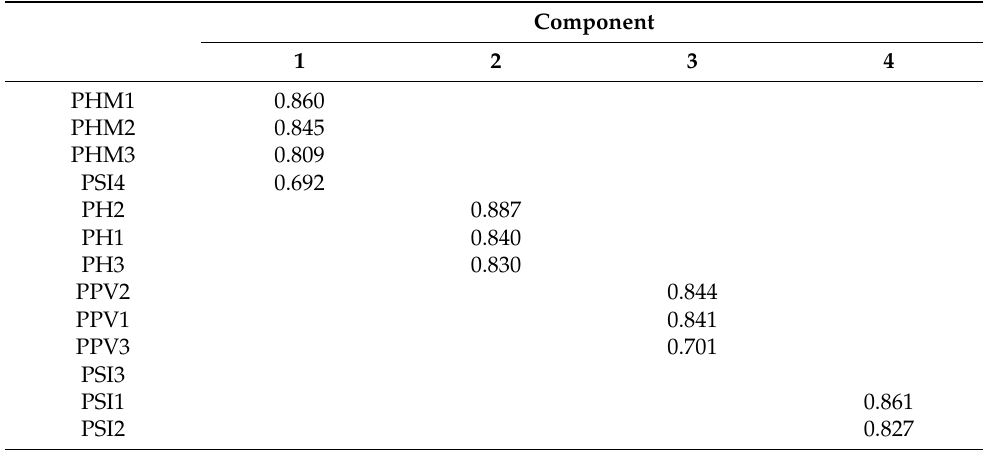
Table A4. Rotated component matrix for pop-up stores (for the purposes of distinguishing between the professions, a prefix ‘P’ was added to the item